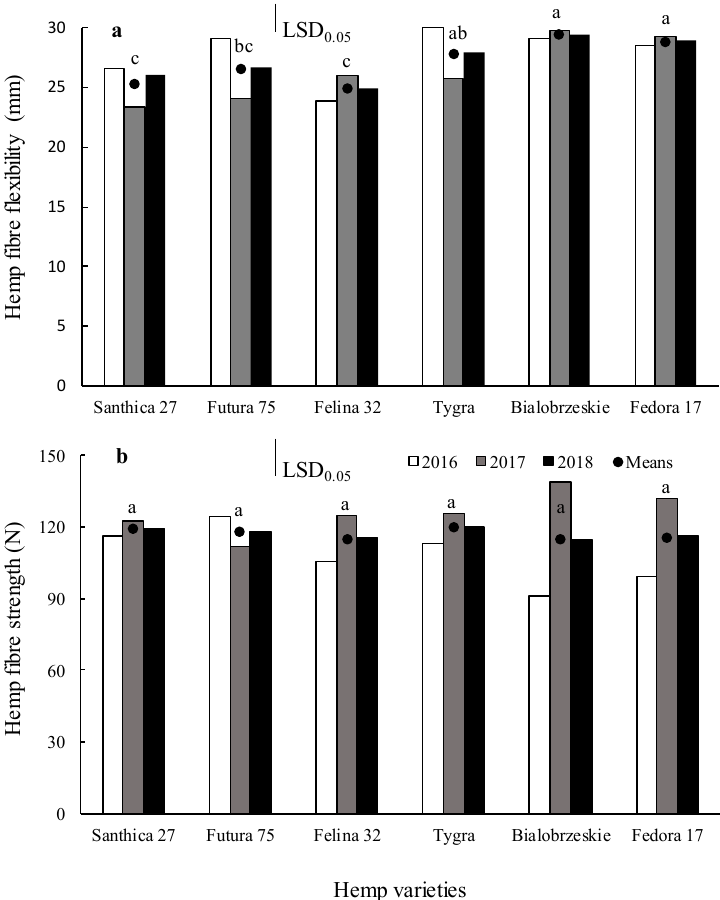
Figure 8. Fibre flexibility ( a ) and fibre strength ( b ) of six industrial hemp varieties. For the year × variety interaction, columns with height differences lower than the LSD height did not significantly differ according to the Fisher’s Protected Least Significant Difference test at p = 0.05. For the variety effect, points with the same letter did not significantly differ according to the Fisher’s Protected Least Significant Difference test at p = 0.05.